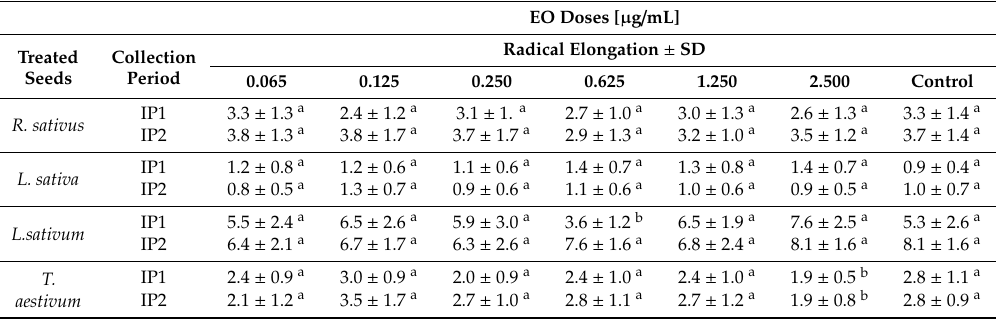
Table 4. E ff ect of di ff erent doses of EO of I. parviflora on the root elongation of three dicot and one monocot model plant